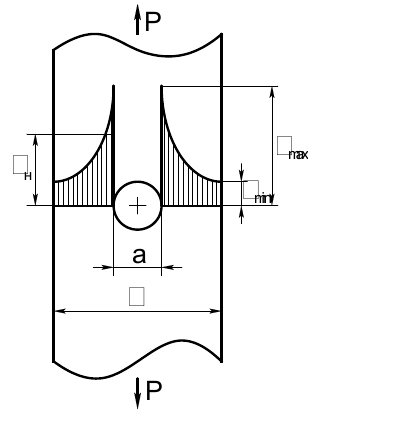
Fig. 1. The element weakened by the presence of a circular hole.